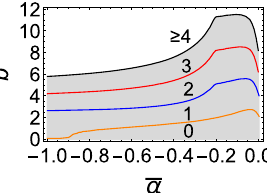
Fig. 9 The relation between the number of the resonances and the T 2 . The number in each region parameters ¯ α and ¯ b for f ( T ) = T + ¯ α k 2 represents the number of the resonances in this region